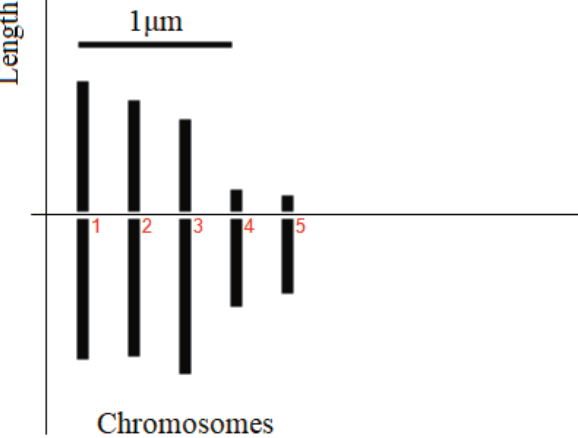
Figure 2. Ideogram of T. embryophagum . Chromosomes are num- bered from the longest (1) to shortest